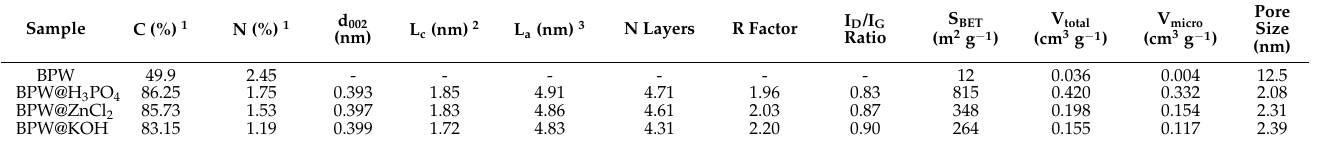
Table 1. Composition, structure, and textural properties for BPW-derived